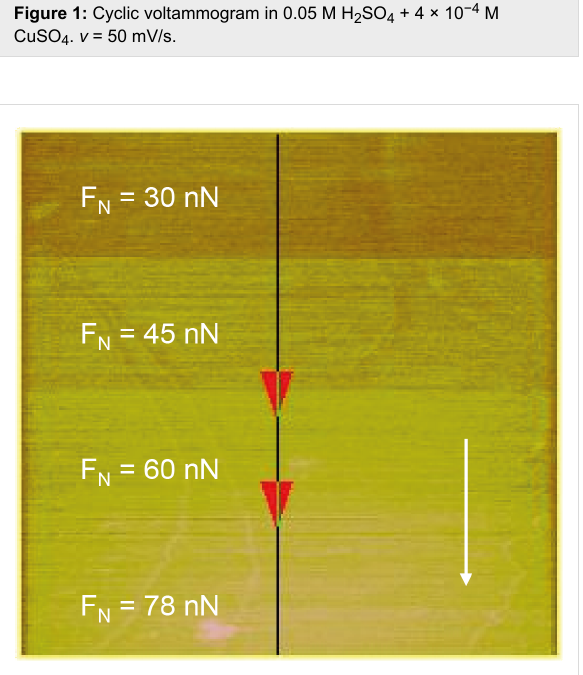
Figure 2: Friction image of Au(111) (in 0.05 M H 2 SO 4 + 4 × 10 − 4 M CuSO 4 ) with a variation of normal load; E = 0.22 V (pzc); image size 600 nm × 600 nm.